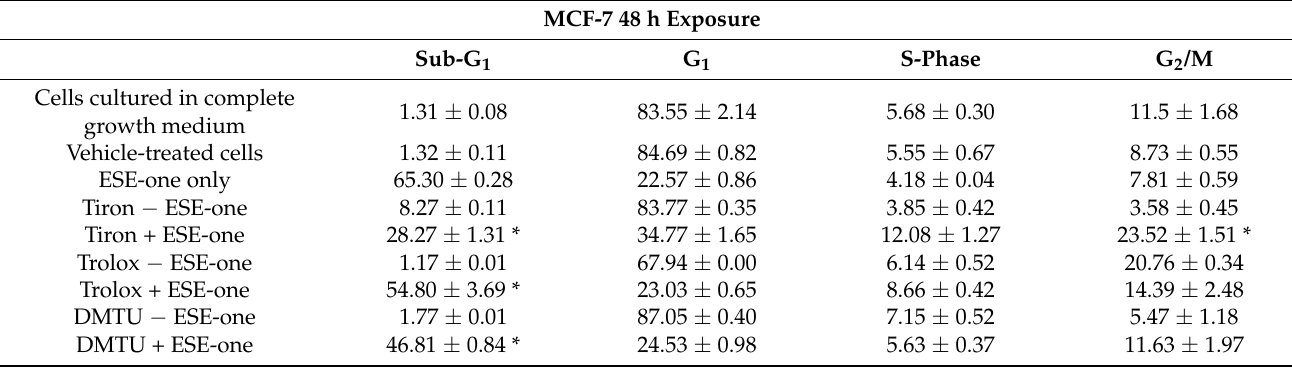
Table 3. Percentage of MCF-7 cells occupying each cell cycle phase as determined by means of flow cytometry using propidium iodide after 48 h exposure. An asterisk (*) indicates p -value ( p < 0.05) compared to ESE-one treated cells.